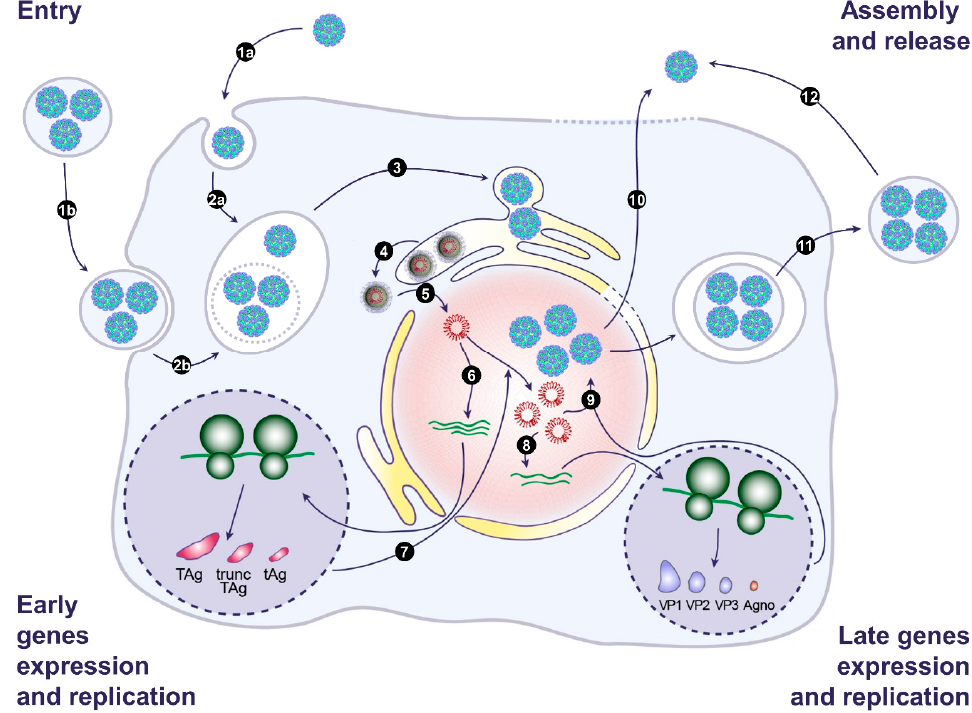
Figure 2. Model of the BK and JC polyomavirus life cycle. ( 1 ) Infection begins with binding of naked virions ( 1a ) or EV-associated virions ( 1b ) to the cell surface. This is followed by endocytosis and transport to the endosomes ( 2a and 2b ). EV membranes may be disrupted by endosomal lipases and lipid extractor proteins to release free virions in the endosomes. Then, viral particles traffic from the endosomes to the endoplasmic reticulum (ER) ( 3 ). In the ER, partial capsid uncoating occurs, which creates a hydrophobic surface exposing VP2/VP3 that integrates into the ER membrane and leads to the release of partially uncoated viruses into the cytosol ( 4 ). The viral genome is then transported into the nucleus via the nuclear pore complex thanks to VP2/VP3 nuclear localization signals and the importin α / β 1 import pathway ( 5 ). Then, early genes are expressed ( 6 ), and early proteins are translocated into the nucleus to initiate viral DNA replication ( 7 ). Late genes are then expressed ( 8 ), and late proteins are translocated into the nucleus. After translocation, VP1, VP2, and VP3 self-assemble to form capsids into which newly synthetized double-stranded viral DNA is packaged ( 9 ). Progeny virions are released from infected cells as naked virions after cell lysis ( 10 ) or through a nonlytic pathway generating EV-associated virions ( 11 ). Free naked viral particles can also derive from EVs, as a result of spontaneous breakage ( 12 ). Adapted from [55].